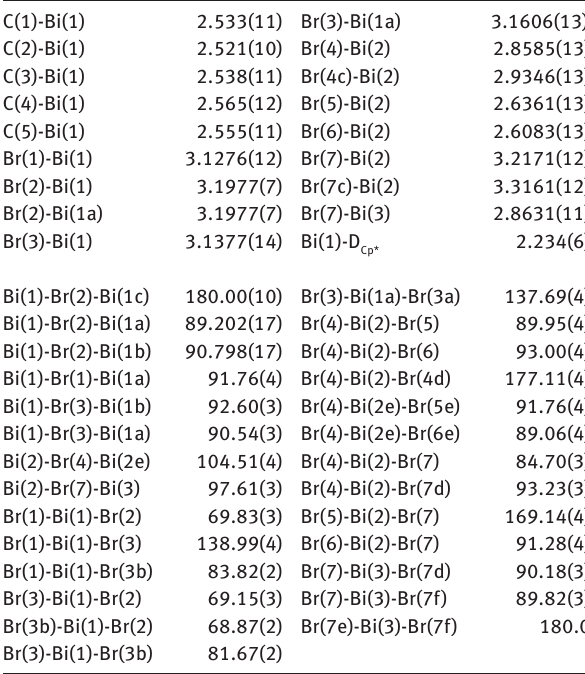
Table 2 Selected interatomic distances [Å] and angles [ ° ] for [Bi Cp* Br ][Bi Br ] ( 1 ). 6 6 9 7 24